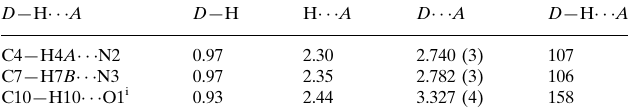
Hydrogen-bond geometry (A˚ , (cid:1)